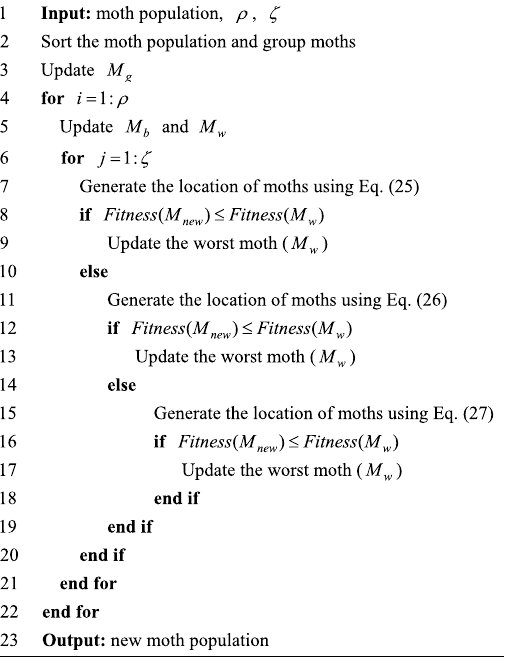
Algorithm 2. Pseudo-code of local search mechanism. Algorithm 3. Pseudo-code of QLSMFO.